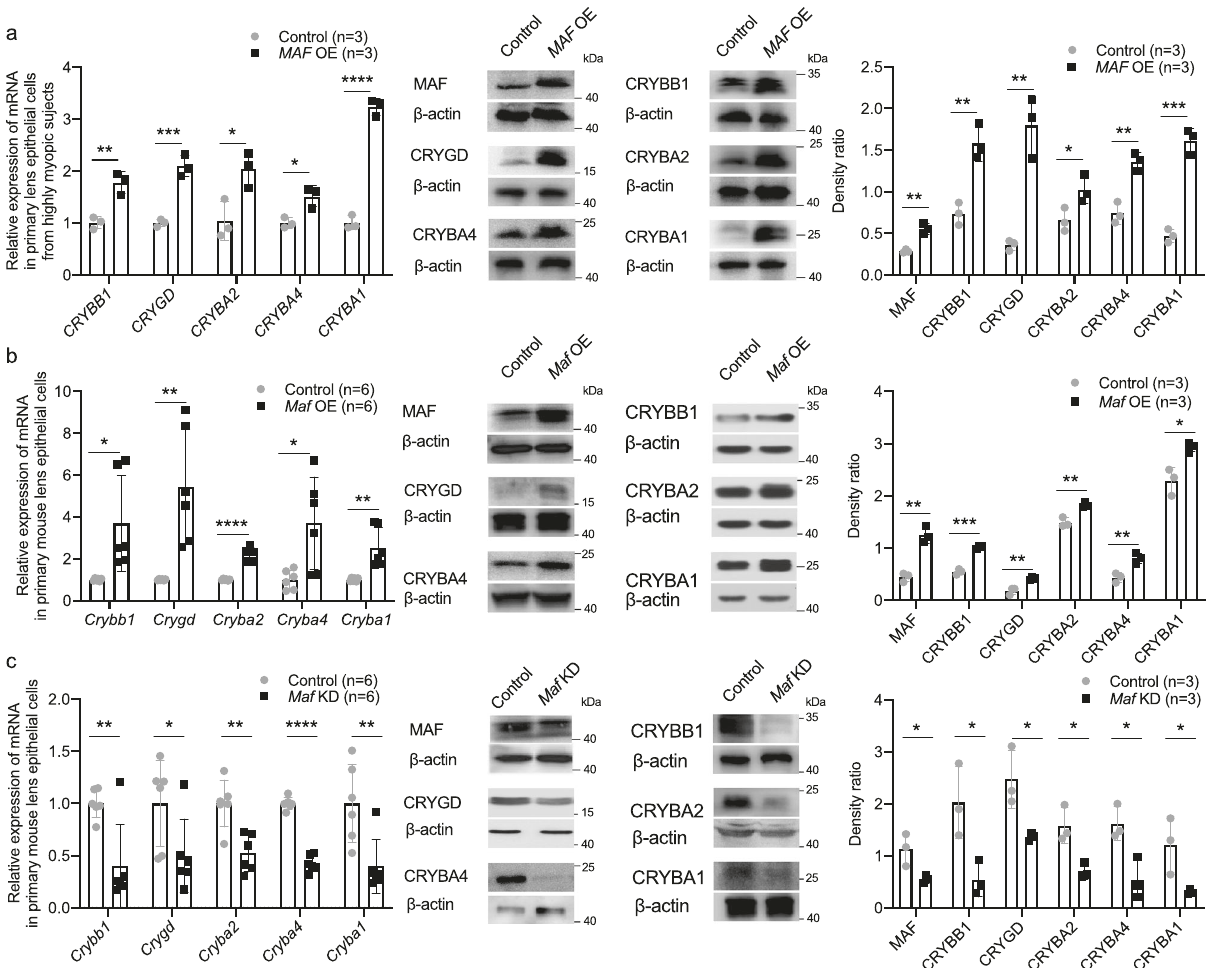
Fig. 5 MAF directly up-regulated β / γ -crystallin expression in high myopia conditions. a Changes of β / γ -crystallin gene expression detected by qPCR ( n = 3, CRYBB1 p = 0.006, CRYGD p = 9.86e-4, CRYBA2 p = 0.026, CRYBA4 p = 0.017, CRYBA1 p = 4.93e − 5) and Western blotting ( n = 3, MAF p